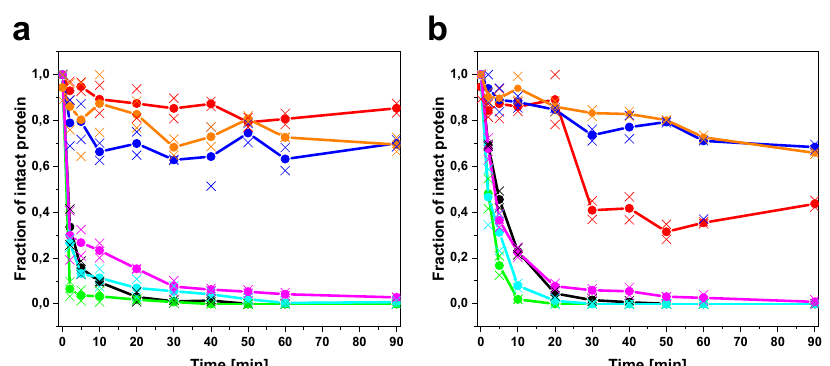
Fig. 5 Limited proteolysis reveals the in fl uence of the C L mutation on LC cleavage. a Limited proteolysis at room temperature with trypsin (substrate/ protease = 20/1). Coloring: P-CL in black, G-CL in red, P-LC in green, G-LC in blue, P-LC G136V in cyan, G-LC V136G in magenta, covalent P-LC homodimer (Bence-Jones dimer) in orange. The mean values are shown as connected dots and the individual data points as crosses. b Limited proteolysis with proteinase K at room temperature (substrate/protease = 250/1). Coloring and symbols as in ( a ). The data are derived from two independent experiments ( n = 2); the single data point of G-LC at 60 min in panel ( b ) was neglected. Source data are given in the Supplementary Data fi